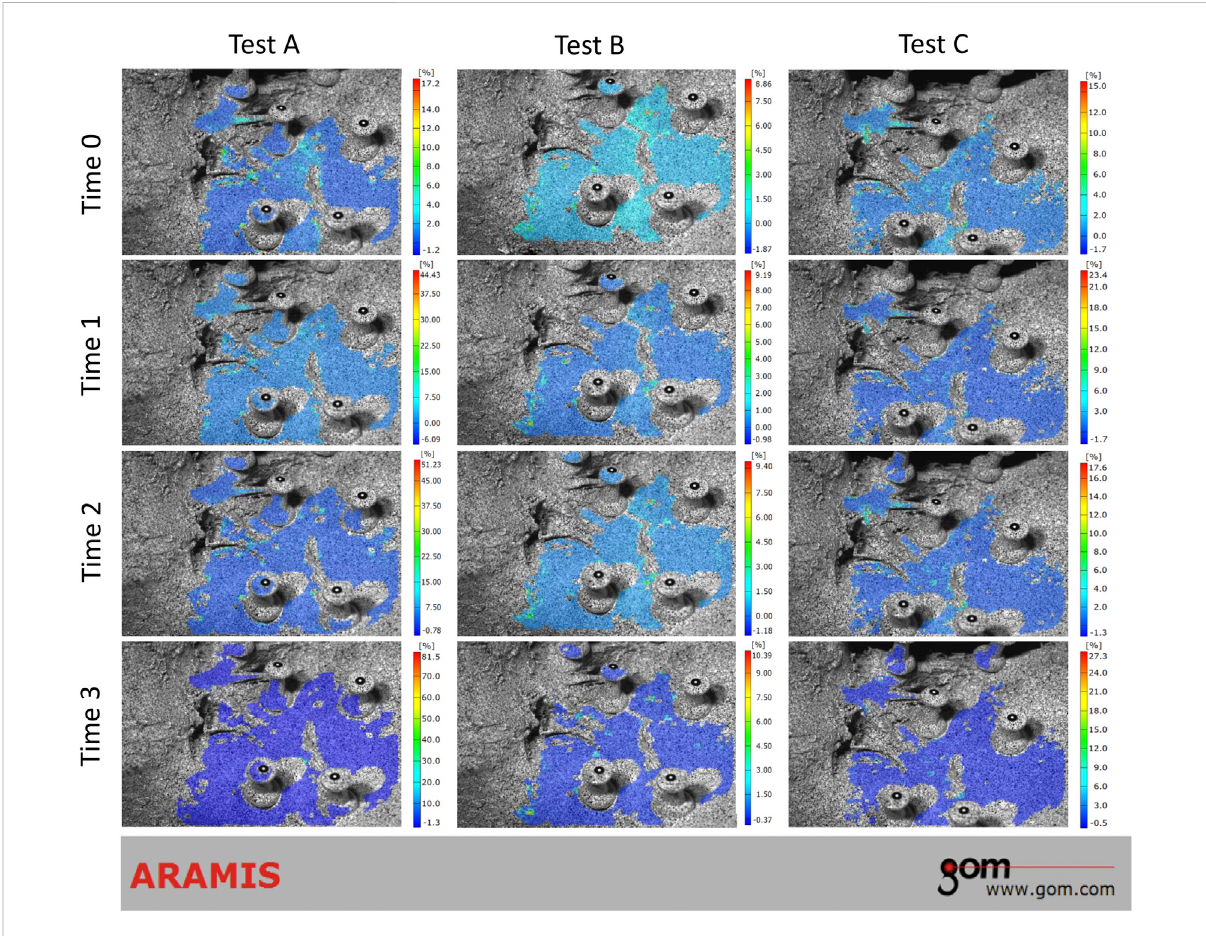
FIGURE 7 Strain trend of the unstable sacroiliac joint with injured pubic symphysis under three tests (unloading phase). Time 0 showed the original conditionwiththemaximumload,whichwasthesameastheendingconditionduringloadingphase.Time1and2showedtheprocessofunloading. Time 3 showed the ending condition without any